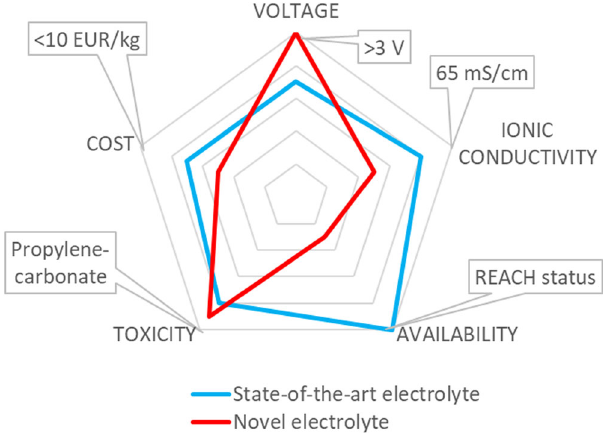
Fig. 2 Comparison between a fi ctional novel electrolyte and a state-of- the-art electrolyte. The innovation potential increases going from the inner to the outer regions of the radar chart. Target values are chosen based on best available option on the market: 3.0 V maximum operating voltage (maximum cell voltage for industrial supercapacitor devices), 65 mS/cm ionic conductivity (using Acetonitrile as a solvent in electrolytes), registered REACH (Registration, Evaluation, Authorisation and Restriction of Chemicals) status for commercial availability, toxicity comparable to Propylene Carbonate (electrolyte component used in various commercial electrochemical energy storage devices) and <10 EUR/kg material cost (cost target for industrial